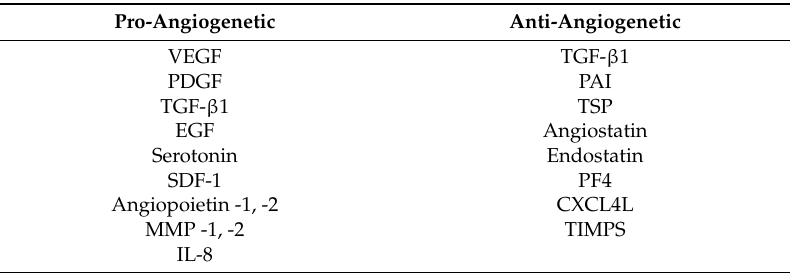
Table 4. Platelet-derived pro and anti-angiogenetic growth factors, originating from α - and dense and adhesion